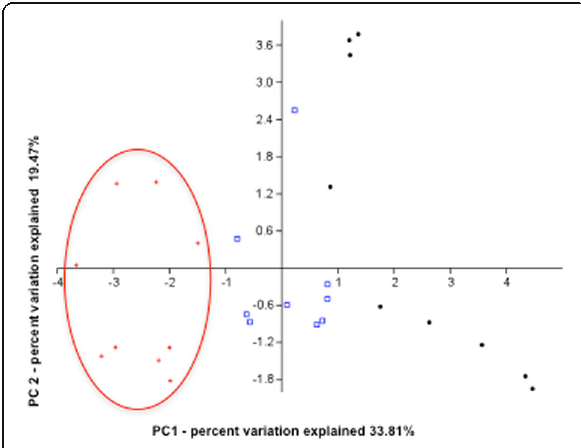
Fig. 4 PCA plot from epididymal WAT immunological profiles. PC1/PC2 score plot showing the distribution of samples in reduced PC1/PC2 space. The percentage variation explained by the plotted principal components is indicated. Symbols refer to individual mice. Red crosses: MBC-supplemented mice; blue squares: LGG- supplemented; black dots: CTRL